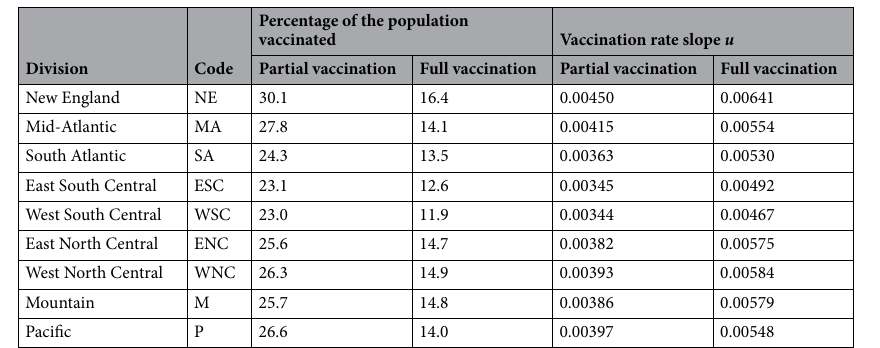
Table 4. Percentage of the population vaccinated with at least one dose and with two doses in each division as of the date of 24th of march 2021.